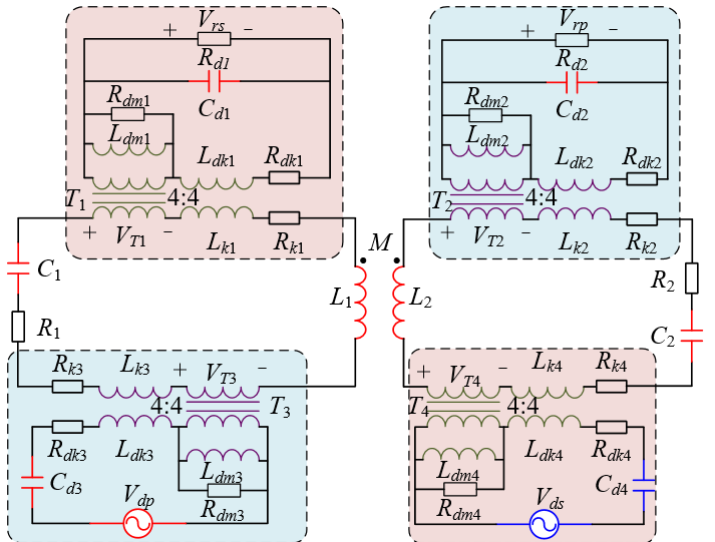
Figure 9. Equivalent circuit of crosstalk interference between forward information transfer and backward information transfer.